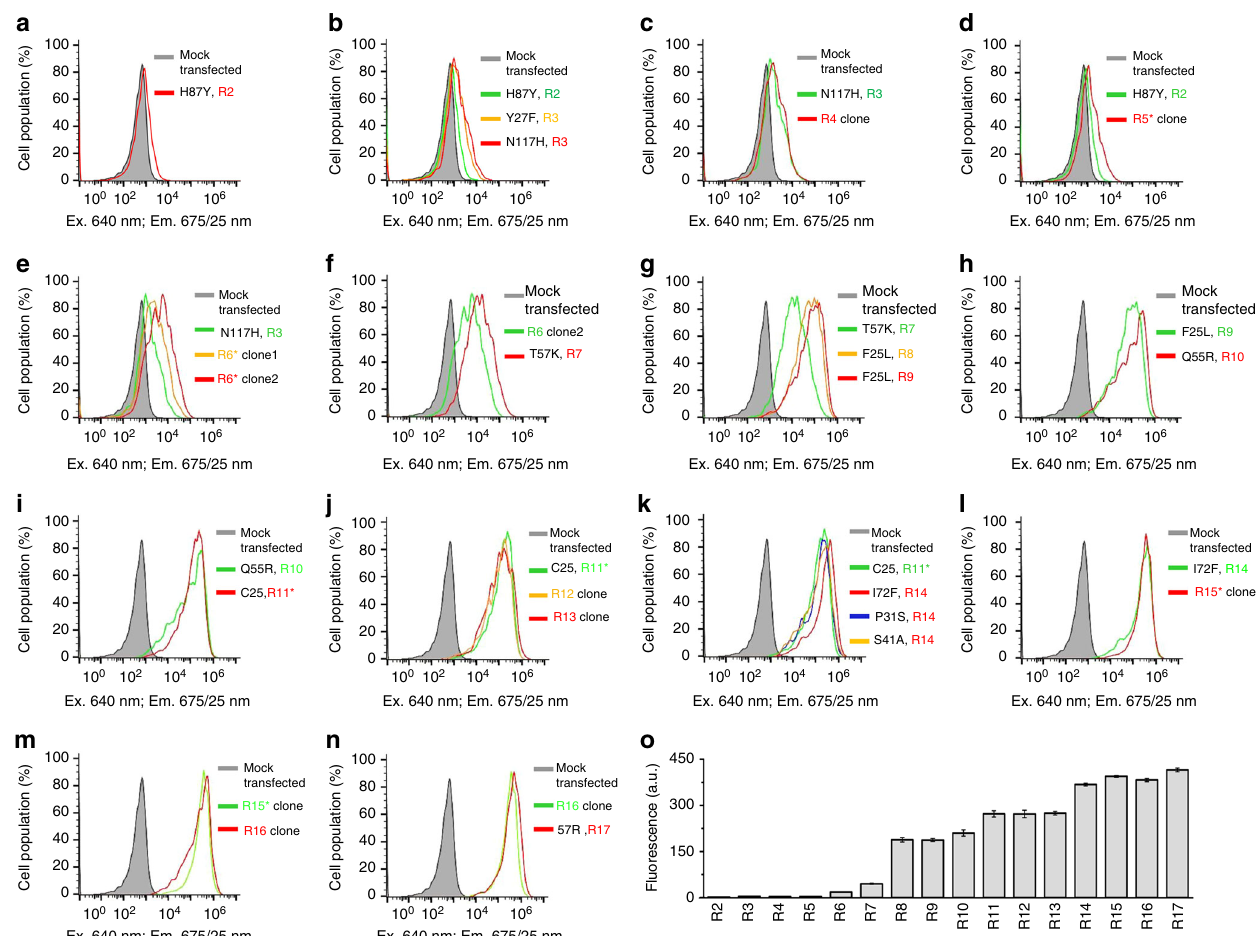
Fig. 1 Molecular engineering of miRFP670nano. a – n Comparison of clones selected on each round of selection in HeLa cells. The main mutations are indicated. o Quanti fi cation of the data represented in a – n . Mean NIR fl uorescence intensity was normalized to mean green fl uorescence intensity of co-expressed EGFP and to mean fl uorescence intensity of mock-transfected cells. Error bars, s.d. ( n = 3; transfection